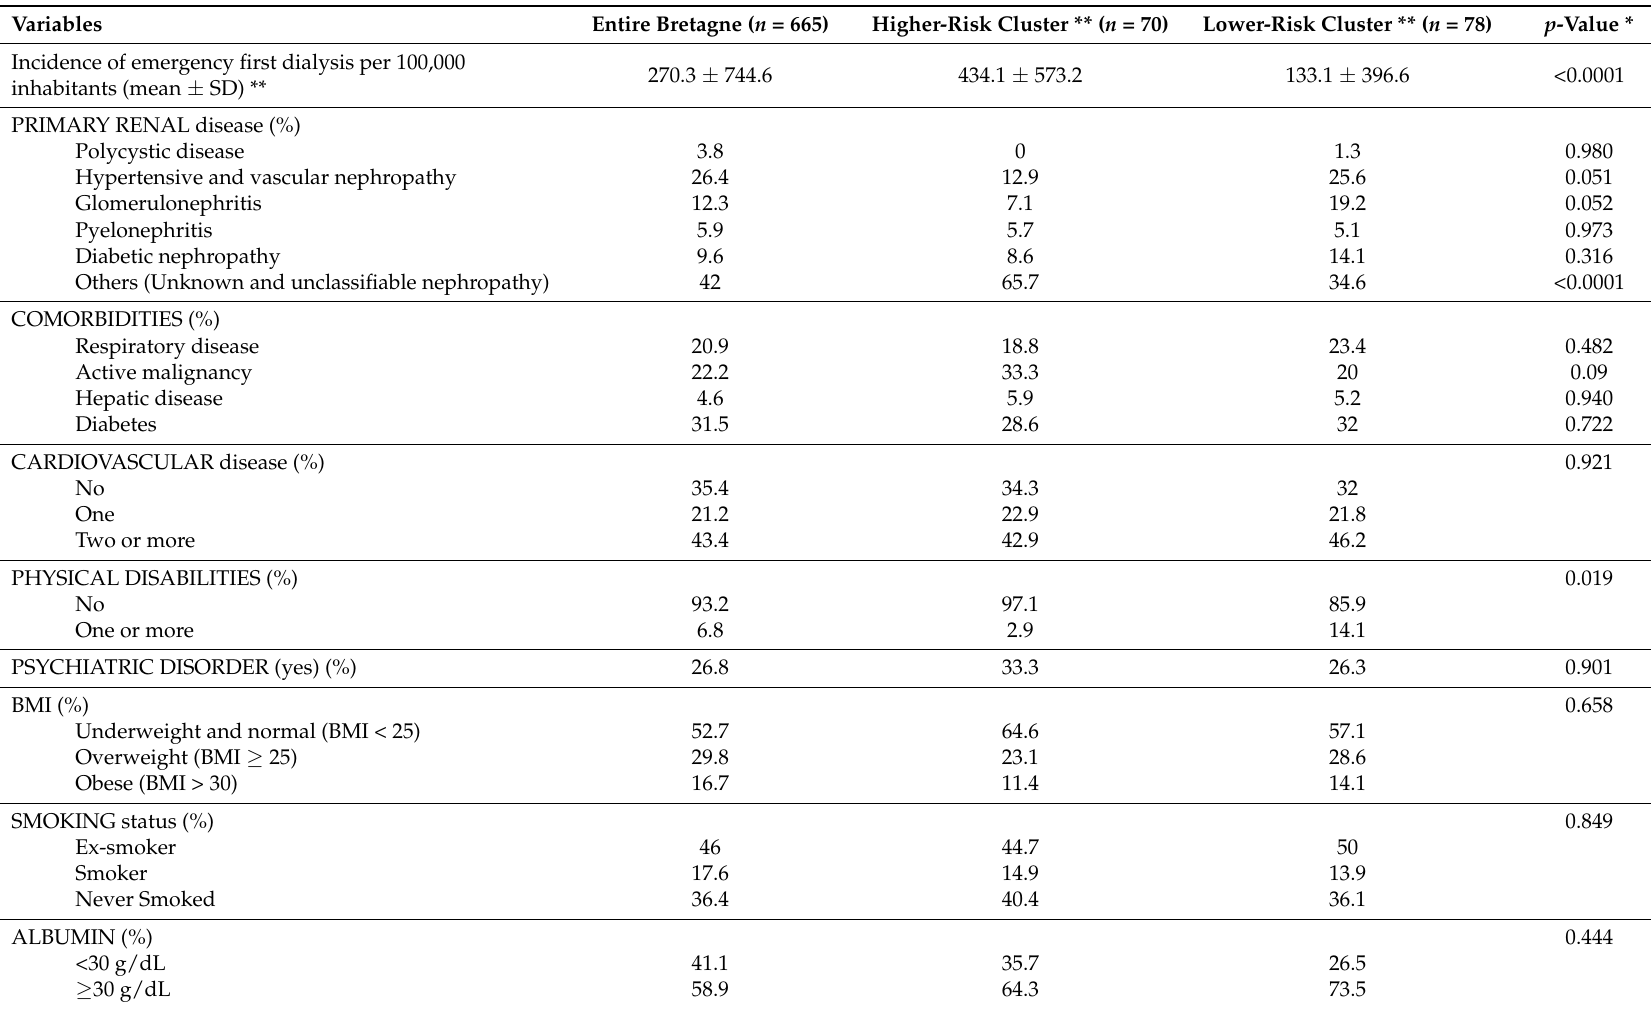
Table 1. Description of the clinical and biological characteristics of the patients with ESRD who started the first dialysis in emergency in the entire Bretagne region and within the higher-risk and lower-risk clusters (no. of patients =